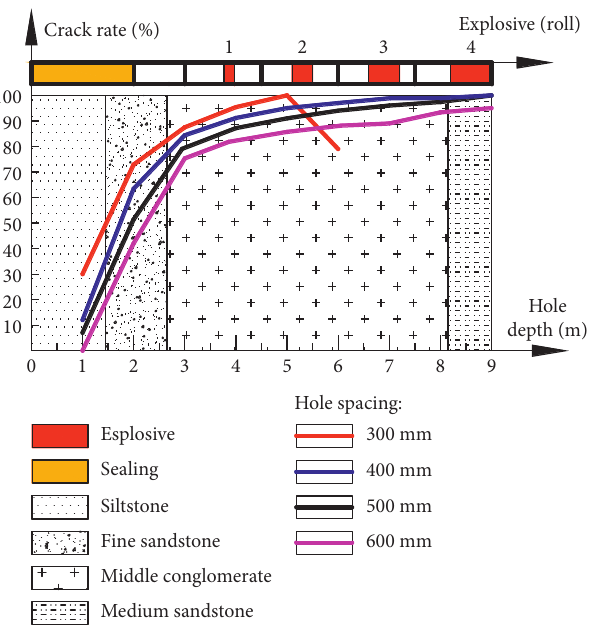
Figure 5: Result of interval-hole blasting